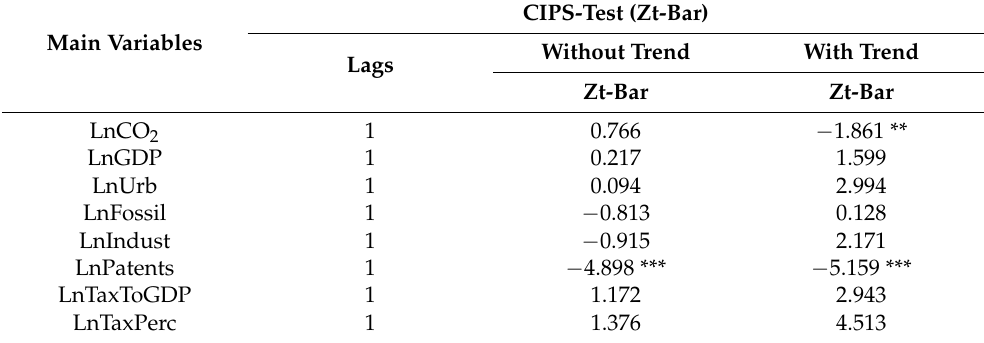
Table 6. CIPS-test.